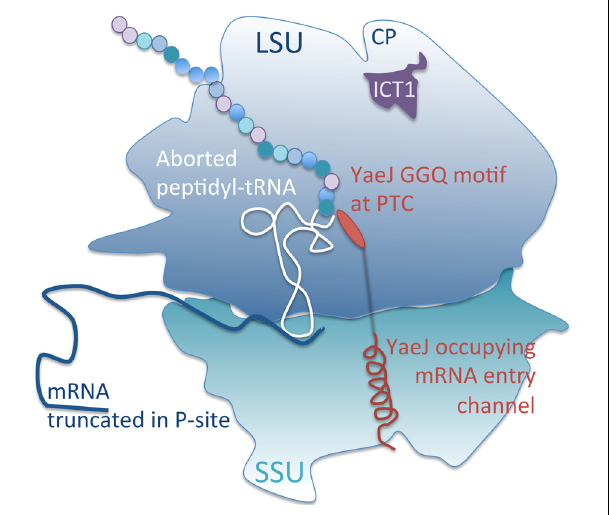
FIGURE 2 | Schematic of a composite ribosome to show relative positions occupied by ICT1 andYaeJ. Truncated mRNA lacking an A-site codon allows ingress ofYaeJ such that the C-terminal α -helix aligns within the mRNA entry channel in the small subunit (SSU).This positions the GGQ motif at the peptidyl transferase centre (PTC) allowing cleavage of the ester bond between the P-site tRNA and the truncated polypeptide (as described in Kogure etal., 2014).The aborted product is then released via the polypeptide exit site in the large subunit (LSU). ICT1 by contrast is located at the central protuberance (CP) precluding its interaction with the nascent peptide without a large scale conformational change of the ribosome (as described in Greber etal.,